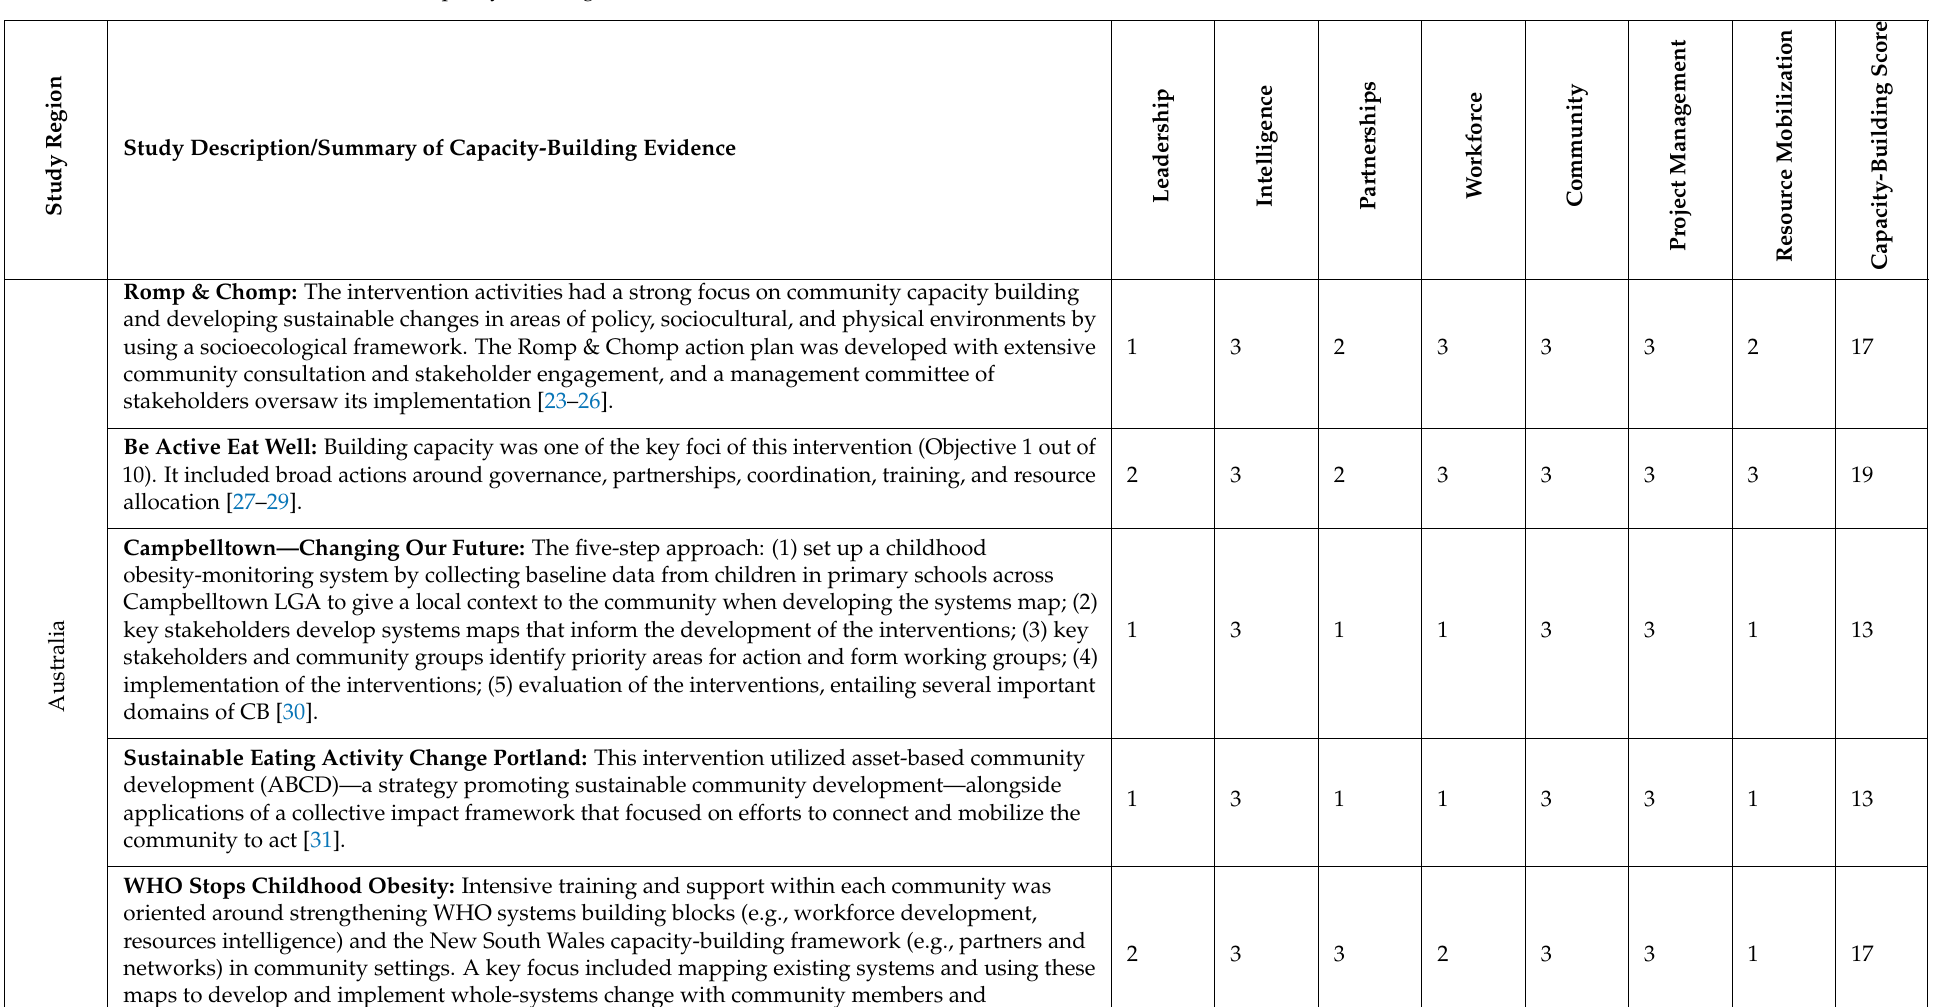
Table 2. Capacity-building